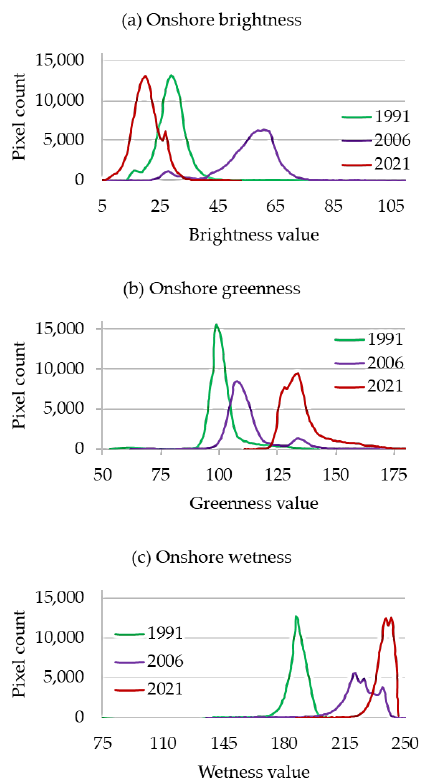
Figure 9. Onshore TCT change statistics: ( a ) brightness, ( b ) greenness, and ( c ) wetness. Onshore Greenness Index The onshore greenness index was made as shore greenness (SG): 𝑆𝐺 1 of the year 1991 (Figure 8d), 𝑆𝐺 2 of the year 2006 (Figure 8e), and 𝑆𝐺 3 of the year 1991 (Figure 8f). The values ranged from 53 to 143 in 1991 (Figure 8d), 62 to 180 in 2006 (Figure 8e), and 111 to 186 in 2021 (Figure 8f). In the 𝑆𝐺 1 of the year 1991, the 88.83%-pixel data valuation was concentrated from 93 to 108 only among 0 to 255. In 2006, 83.16% of the pixels were ag- glomerated from 101 to 120 ( 𝑆𝐺 2 ), and 88.10% ranged from 123 to 147 greenness index values in 2021 ( 𝑆𝐺 3 ). Therefore, onshore greenness increased frequently from 1991 to 2006 and 2006 to 2021 (Figure 9b). Onshore Wetness Index The onshore wetness index was arranged as follows: 𝑆𝑊 1 of the year 1991 (Figure 8g), 𝑆𝑊 2 of the year 2006 (Figure 8h), and 𝑆𝑊 3 of the year 1991 (Figure 8i). The values ranged accordingly from 75 to 215 in 1991 (Figure 8g), 135 to 250 in 2006 (Figure 8h), and 187 to 246 in 2021 (Figure 8i). In the 𝑆𝑊 1 of the year 1991, the 87.73%-pixel data valuation